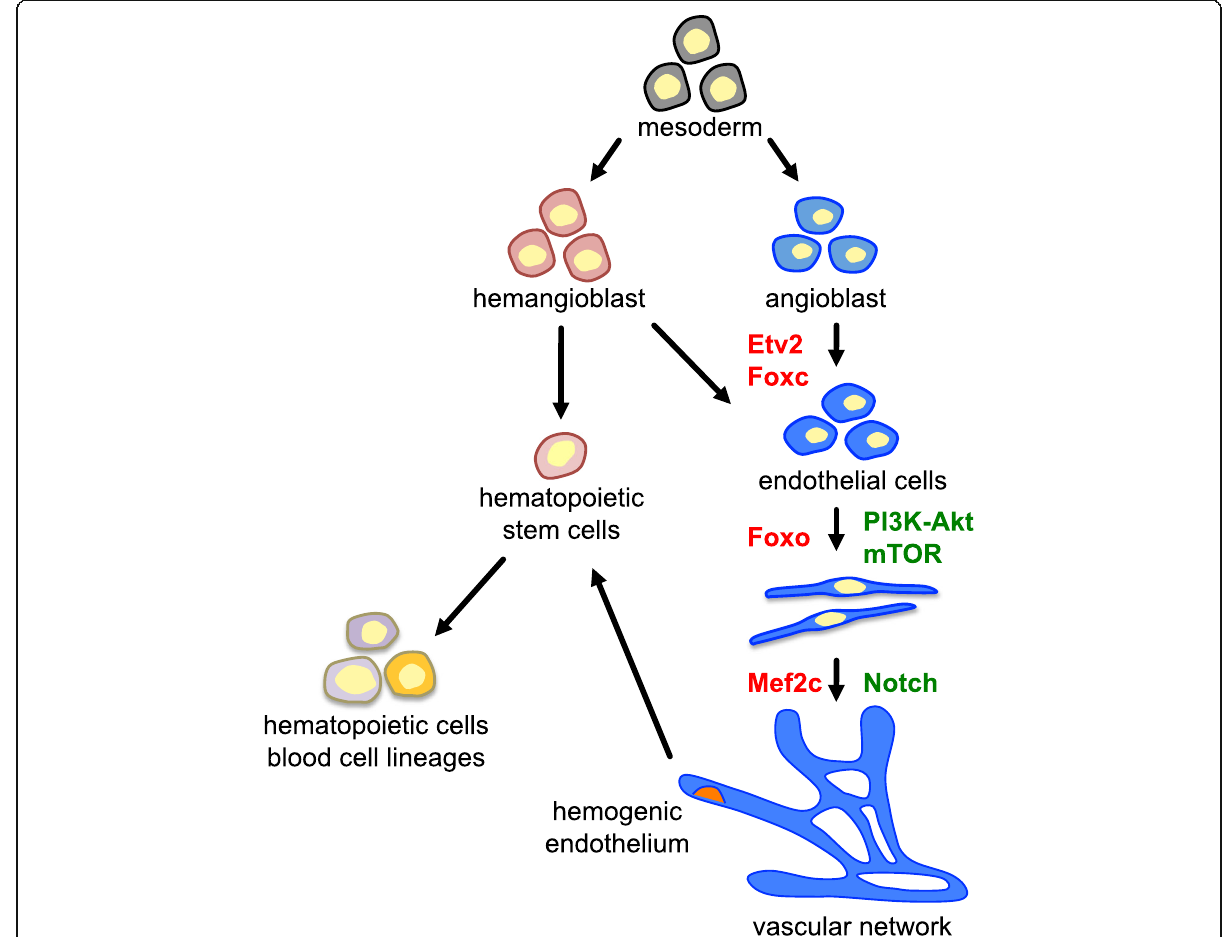
Fig. 1 Schematic model of early vascular development. Endothelial cells are derived from mesodermal precursors: angioblasts and hemangioblasts. They form vascular networks by undergoing morphological changes. Possible transcription factors (red) and signaling molecules (green) controlling each process are shown. During early vascular development, hematopoietic lineages arise from hemangioblasts or hemogenic